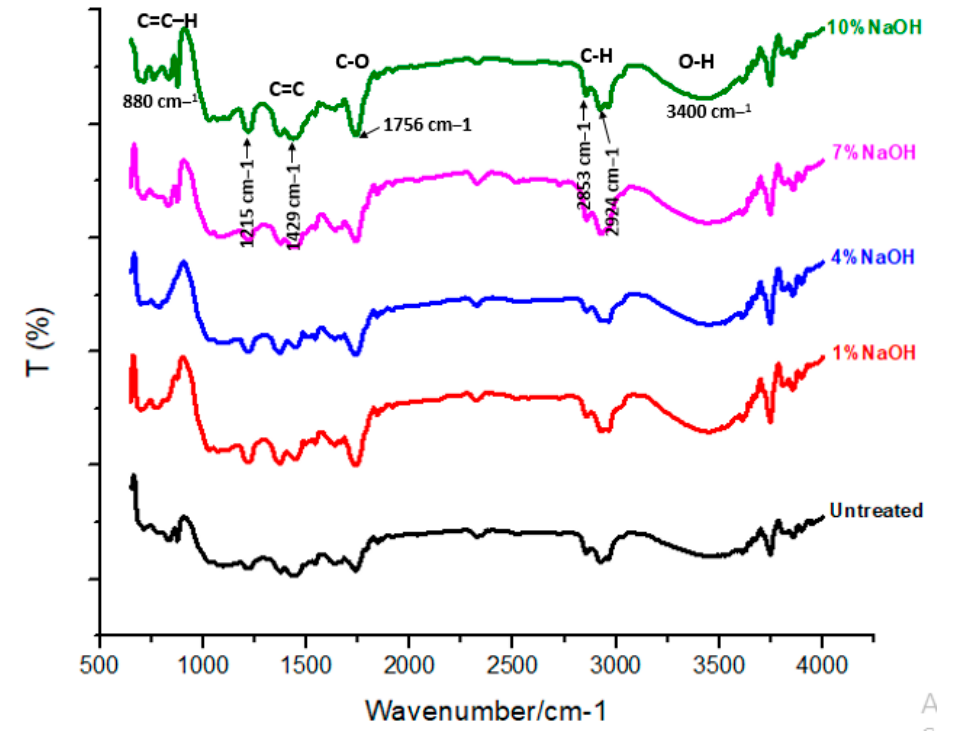
Figure 5. FTIR spectra for untreated rubber crumbs and treated rubber crumbs with different NaOH concentrations.